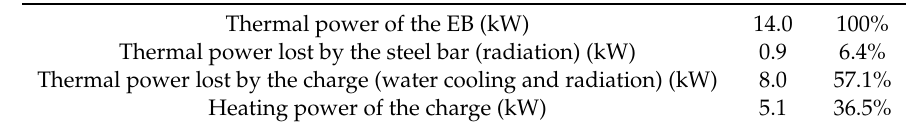
Table 6. Heat thermal balance at t = 40